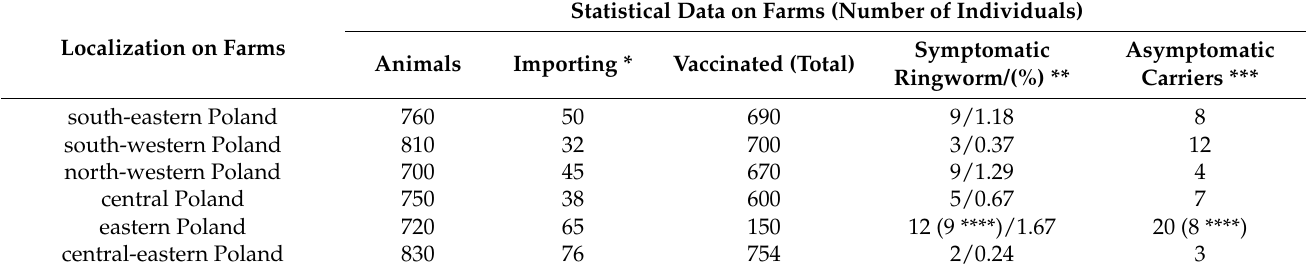
Table 1. Data related to the cattle farms where the study was performed.